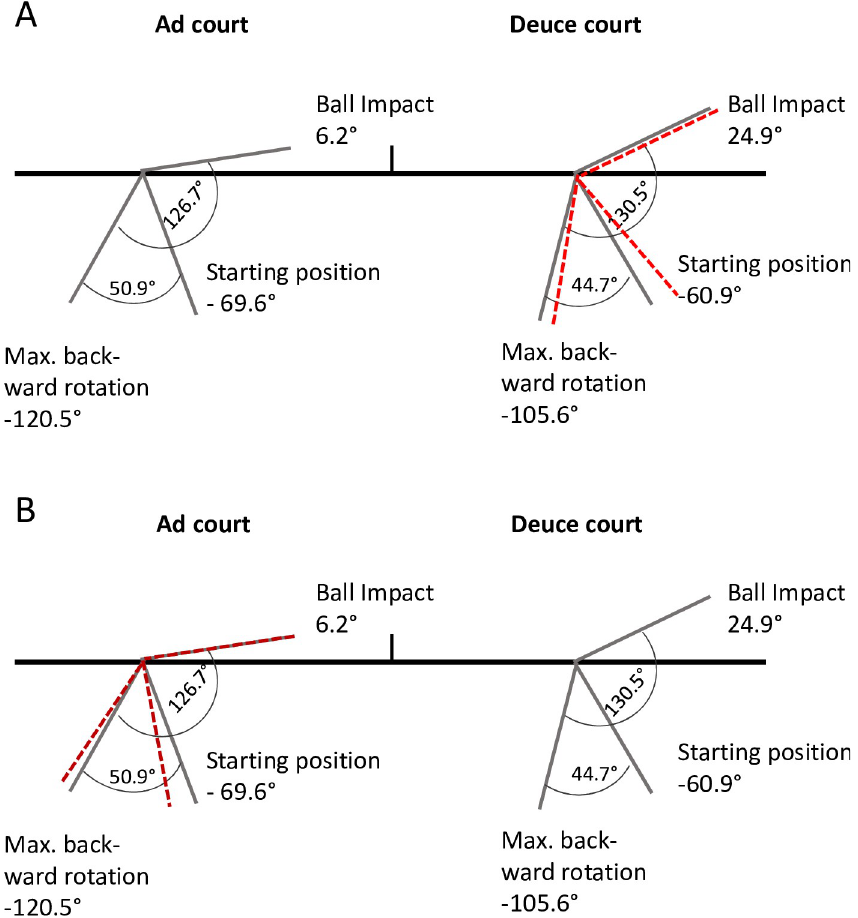
Fig 3. Upper torso rotation at start, maximum backward rotation (clockwise), and impact on ad and deuce court side. A) red line: mirror image transferred from the ad court kinematics to the deuce court (total ROM: 126.7˚, counter-rotation ROM: 50.9˚); B) red line: mirror image transferred from the deuce court kinematics to the ad court (total ROM: 130.5˚, counter-rotation ROM: